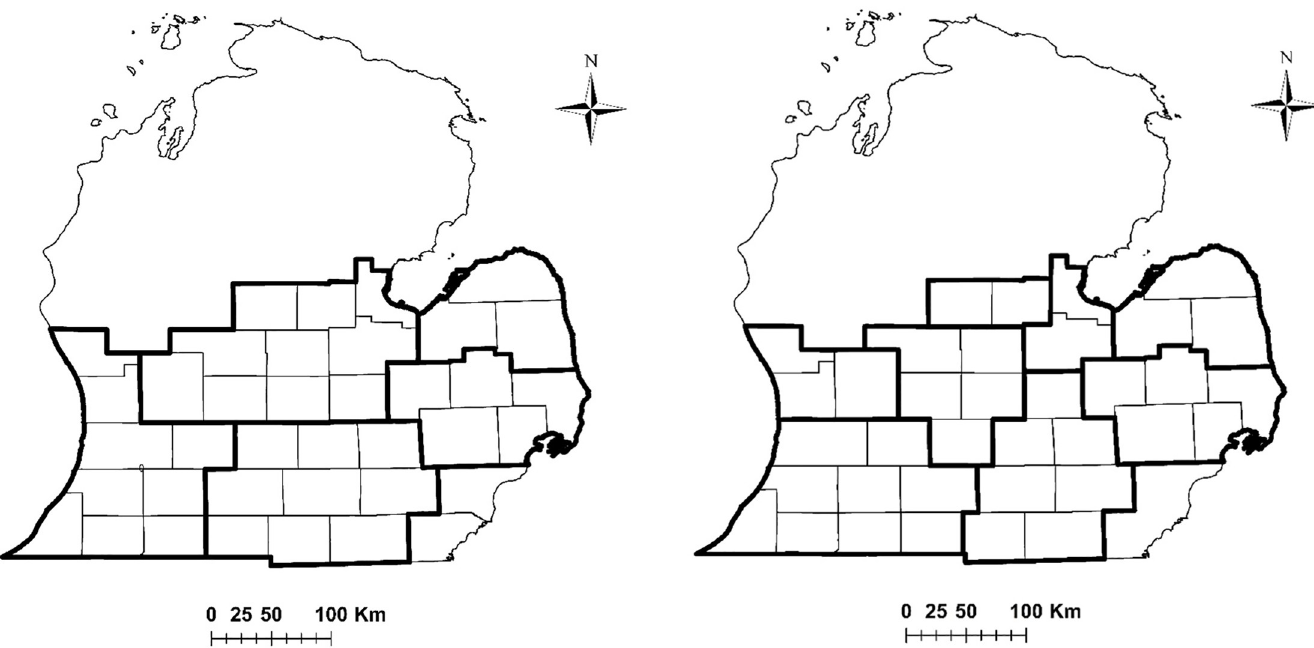
Fig 1. Wild turkey harvest management regions and counties open to spring (A) and fall (B) hunting in southern Michigan, USA, where we assessed dynamics and drivers of wild turkey hunter populations. Management regions are outlined in bold to denote their location within the lower peninsula of Michigan, and counties open to hunting are indicated (thin black